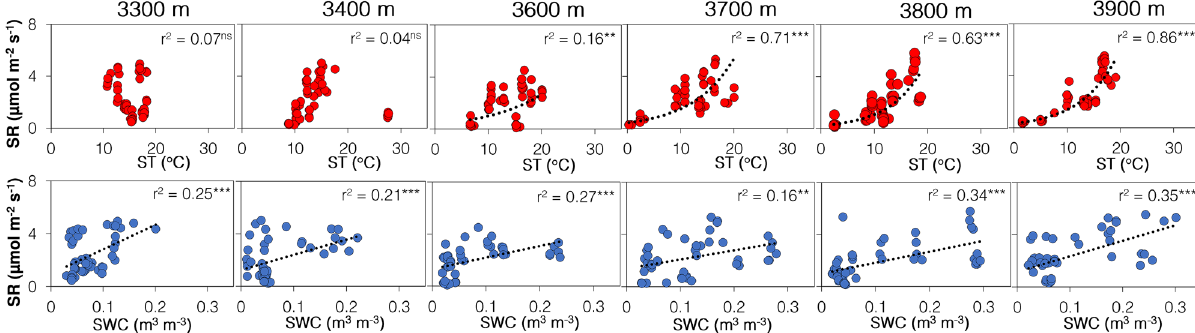
Figure 2. Effect of soil temperature and moisture on SR. Exponential and linear models between SR and soil temperature (ST) and SR and volumetric soil water content (SWC) at different elevations. r 2 depicts the strength of the model significant at *** p < 0.001 and ** p < 0.01 while ns represents non-significant relationship with total data points = 48. See also Supplementary Table S2 online for intercepts, slope, and exact p values in the model. Elevation (m)